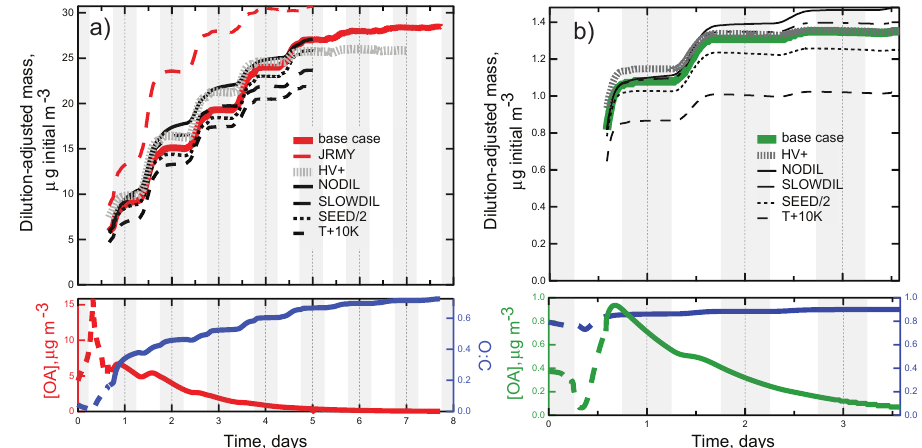
Figure 2. Simulated aerosol development for the (a) urban and (b) forest cases. Upper panels show plume-integrated mass during the outflow phase; lower panels show concentrations and O:C ratios for the model-generated aerosol fraction in the source regions and outflow phases. Grey shading indicates approximate nighttime periods.